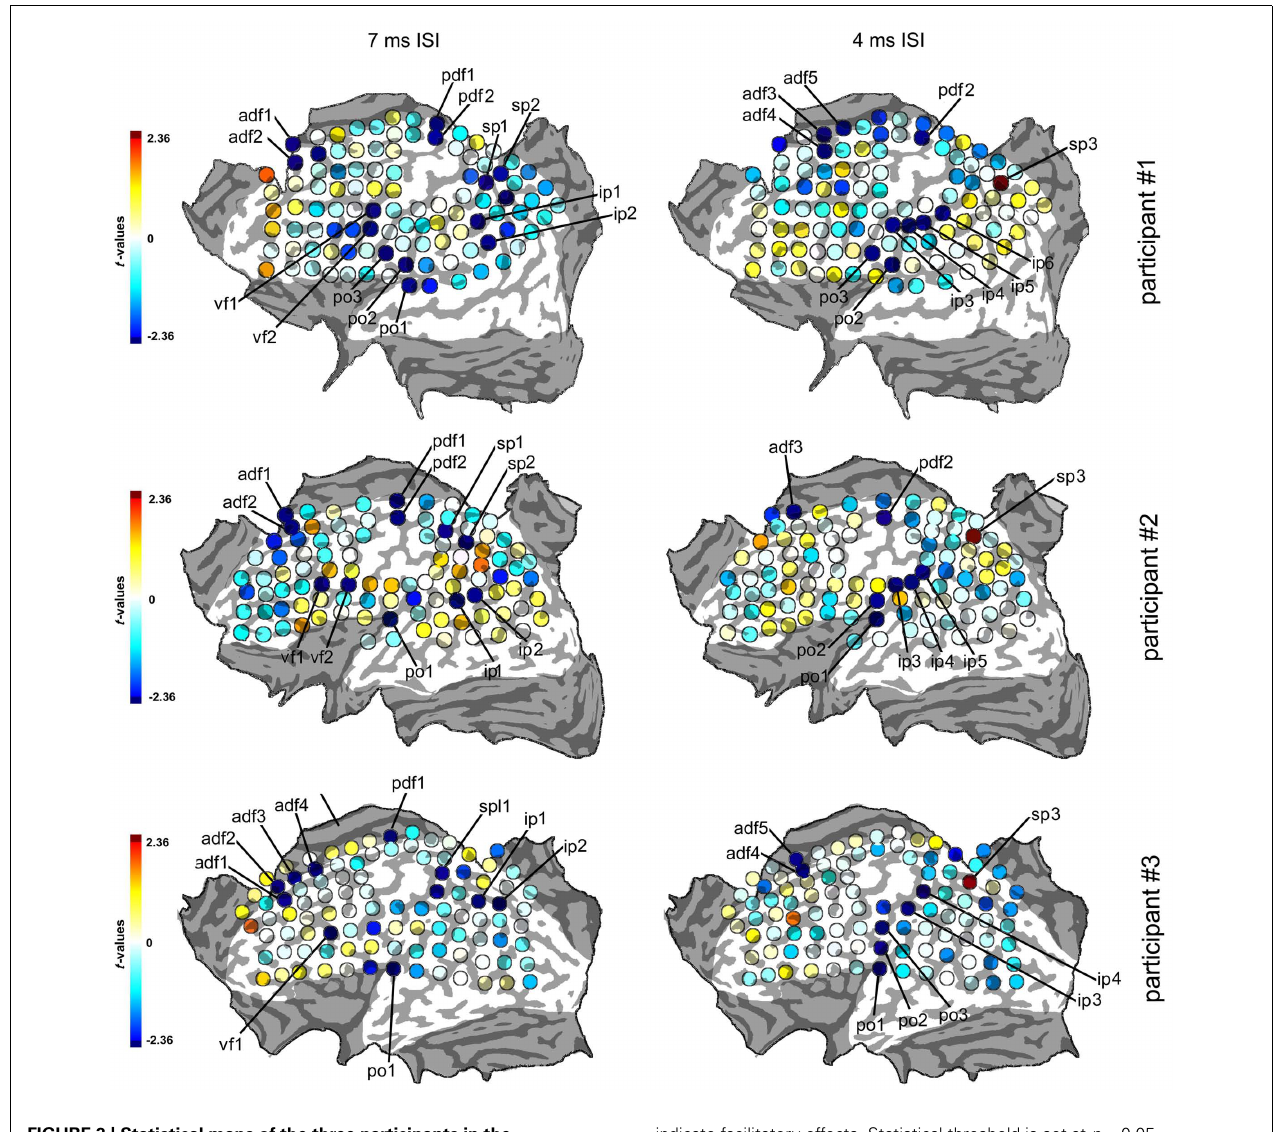
FIGURE 3 | Statistical maps of the three participants in the 7 and 4ms ISIs. The color scale of the spots indicates the values of the statistical parameter t obtained with single-sample t -tests comparing the normalized, log-transformed cTMS + tTMS MEPs to the average value of 0. Negative (blue) values indicate inhibitory effects of cTMS on tTMS while positive (red) values